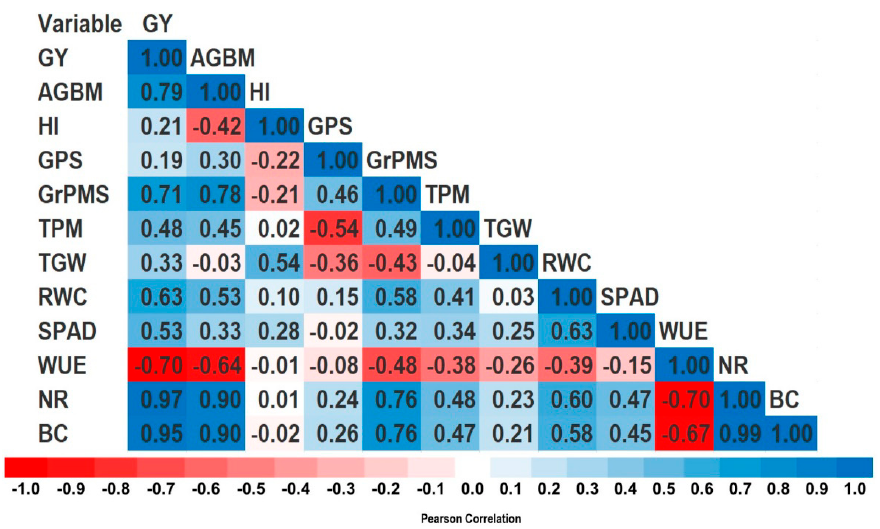
Figure 7. Correlations between GY, Yield attributing traits and physiological parameters.